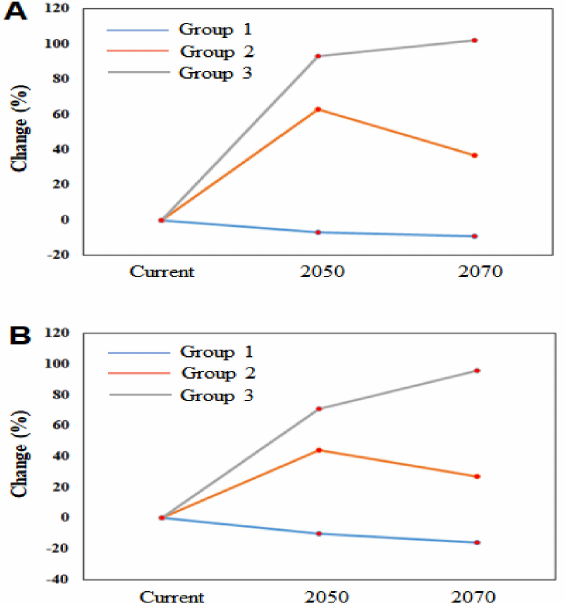
Figure 5. Percentage change in the extent of the average spatial distribution of alien plant species in group 1, group 2, and group 3, under the climate change scenarios RCP 4.5 ( A ) and RCP 8.5 ( B ). The details of each group are presented in Table 1.